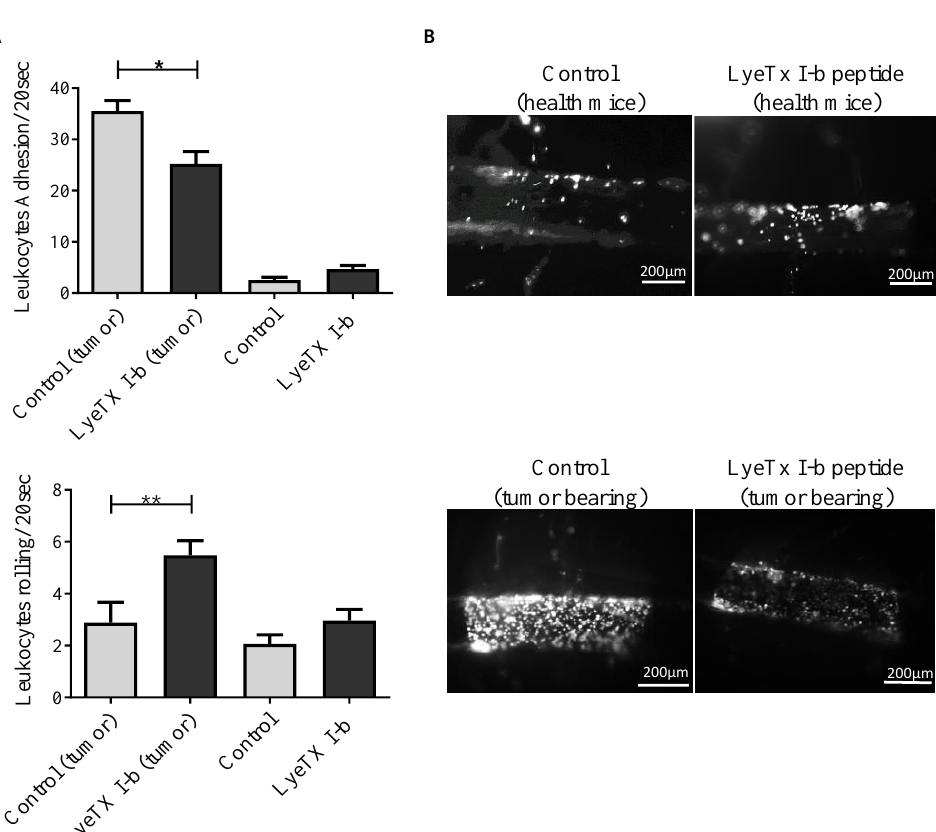
Figure 11. Evaluation of in vivo leukocyte recruitment by intravital microscopy, on day22 post-inoculation of 4T1 tumor cells. ( A ) Number of rolling and adhering leukocytes in health and tumor-bearing mice. Both control groups received 100 µ L of saline, and treated groups received 5 mg/kg of LyeTx I-b dissolved in saline subcutaneously (5 doses/72 h apart). ( B ) Representative images of blood vessels of the spinal cord show the impact of LyeTx I-b treatment on leukocyte-endothelial interactions; higher numbers of adherent leukocytes in tumor-bearing control compared to the treated group were observed. Statistical analysis: Data are presented as the mean ± SD, * p < 0.05; ** p < 0.01, n = 6 animals. One-way ANOVA followed by Tukey ’ s multiple comparisons test.